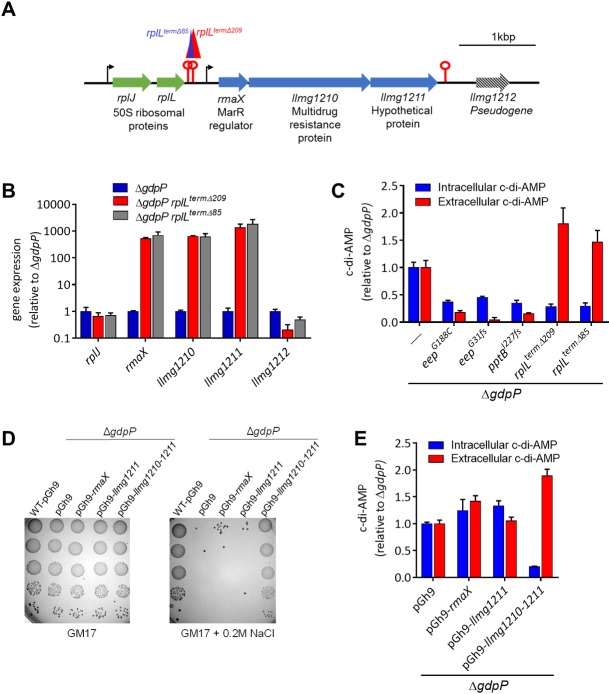
Active export of c-di-AMP lowers intracellular c-di-AMP and restores osmoresistance in Lc. lactis ΔgdpP.(A) Location of two independent intergenic deletions between rplL and rmaX. Arrows and lollipops indicate predicted transcription start sites and terminators, respectively. (B) Expression of genes in ΔgdpP and the two suppressor mutants containing intergenic deletions (ΔgdpP rplLtermΔ209 and ΔgdpP rplLtermΔ85) using qRT-PCR. (C) Levels of intracellular and extracellular c-di-AMP in ΔgdpP and osmoresistant suppressor derivatives. Data are the mean ± SEM from three independent biological replications. (D) Comparison of growth of strains on GM17 agar or GM17 agar + 0.2M NaCl following spotting of serial dilutions. Includes ΔgdpP strains overexpressing different genes in pGh9 plasmid using the promoter from rplJ. (E) Levels of intracellular and extracellular c-di-AMP in ΔgdpP strains overexpressing different genes from the pGh9 plasmid using the promoter from rplJ. Data are the mean ± SEM from three independent biological replications.